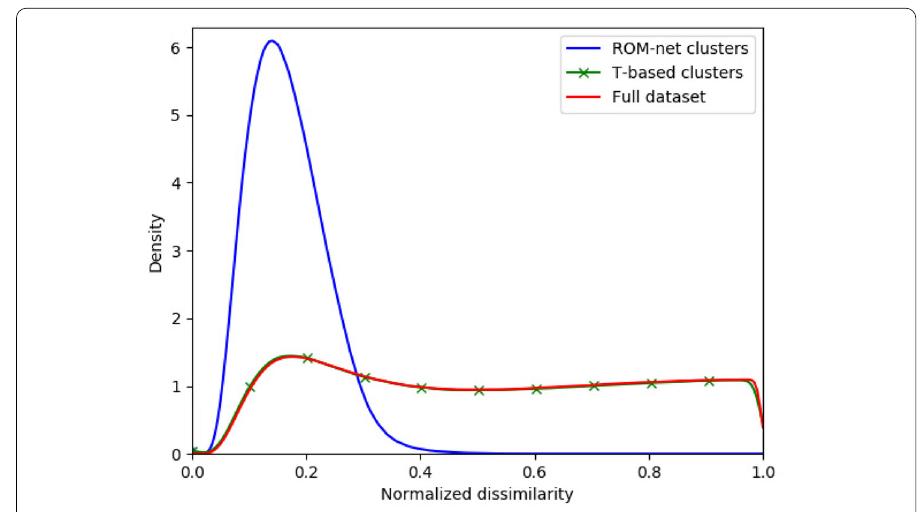
Fig. 13 Distributions of intra-cluster ROM-oriented